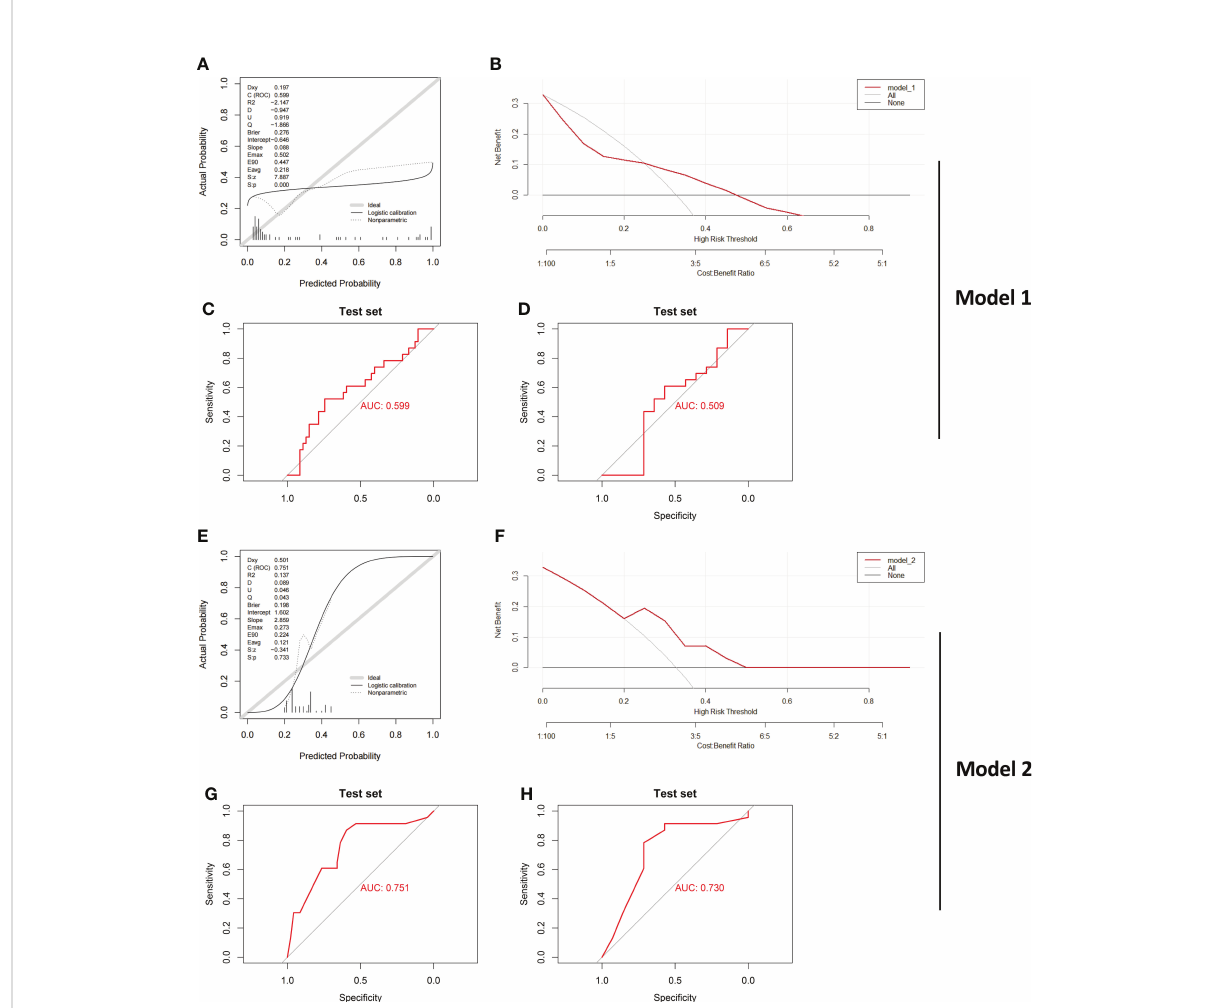
FIGURE 7 Veri fi cation of the effect of both Model_1 and Model_2 in a new IBD Cohort Calibration curves (A) , DCA curve (B) and ROC curve (C) testing the effect of Model_1 in GSE179285 are illustrated. CD and UC samples from colon tissue only were further examined by Model_1, and (D) ROC curve is shown. Calibration curves (E) , DCA curve (F) and ROC curve (G) testing the effect of Model_2 in GSE179285 are illustrated. CD and UC samples from colon tissue only were further examined by Model_2, and (H) ROC curve is shown. CD/UC=37/23 is the sample size in GSE179285, and CD/UC=14/23 is the sample size in GSE179285 including only colon